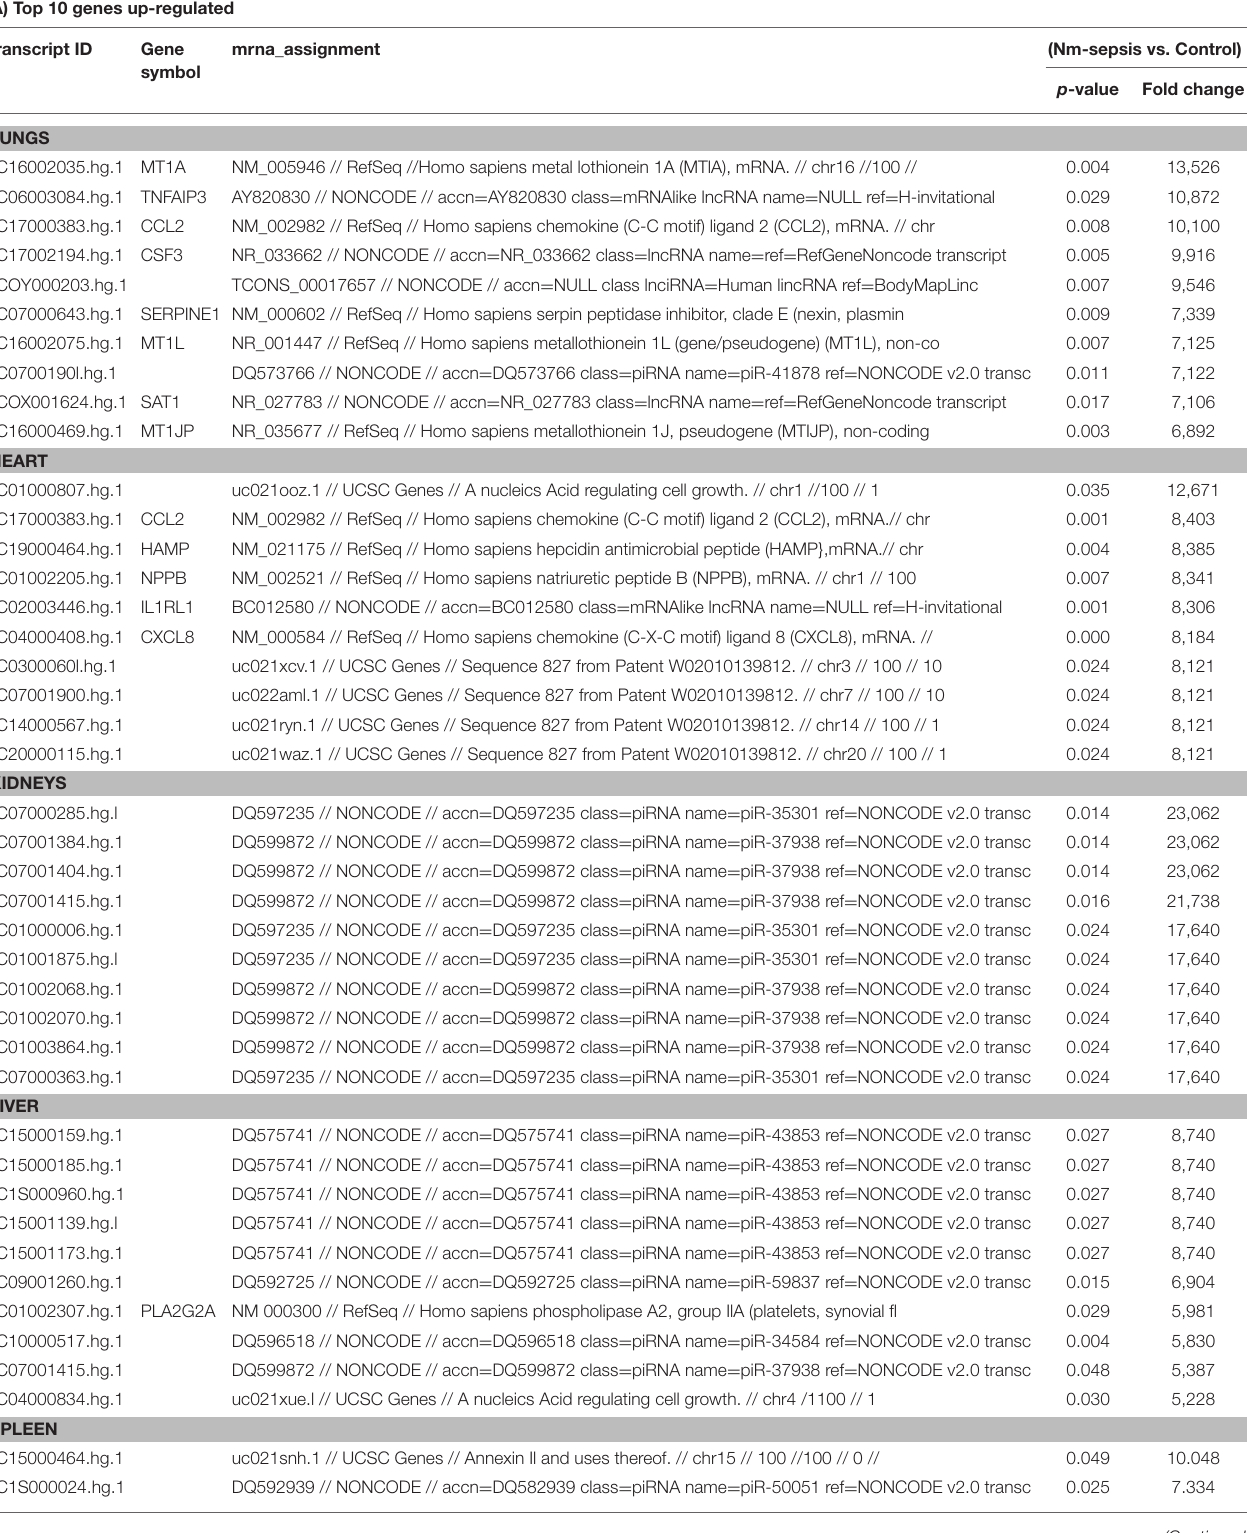
TABLE 3 | Top 10 differentially expressed up-regulated (A) and down-regulated (B) gene transcripts in large organs from patients with meningococcal septic shock vs. controls. (A) Top 10 genes